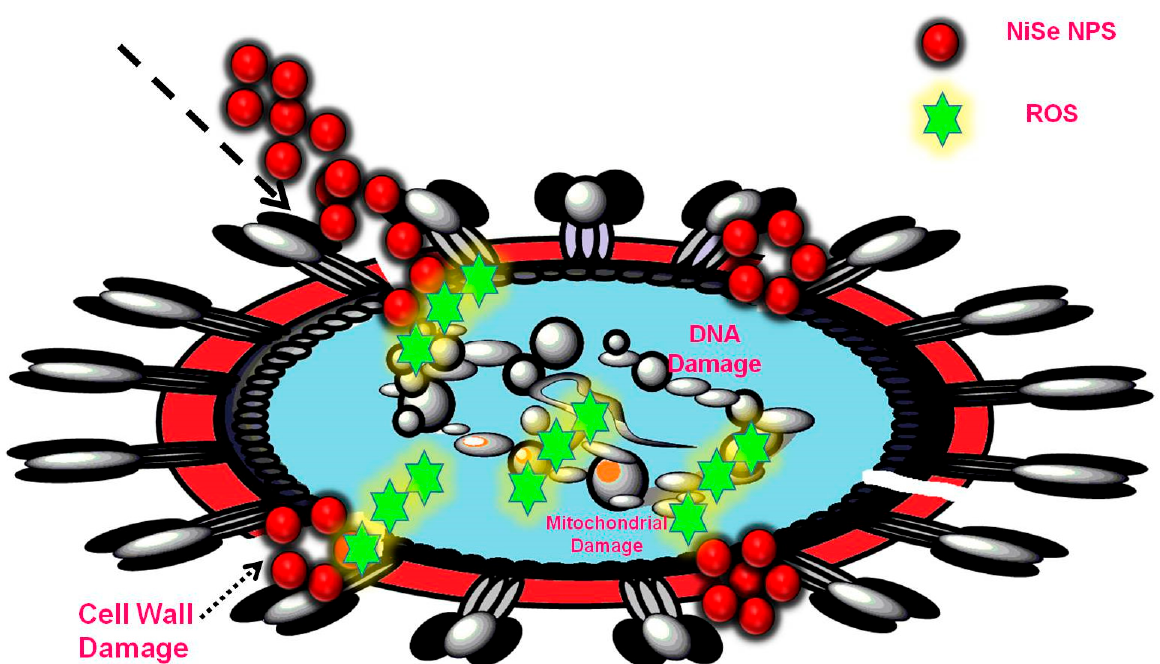
Figure 10. Antimicrobial activity mechanism of NiSe NPs.